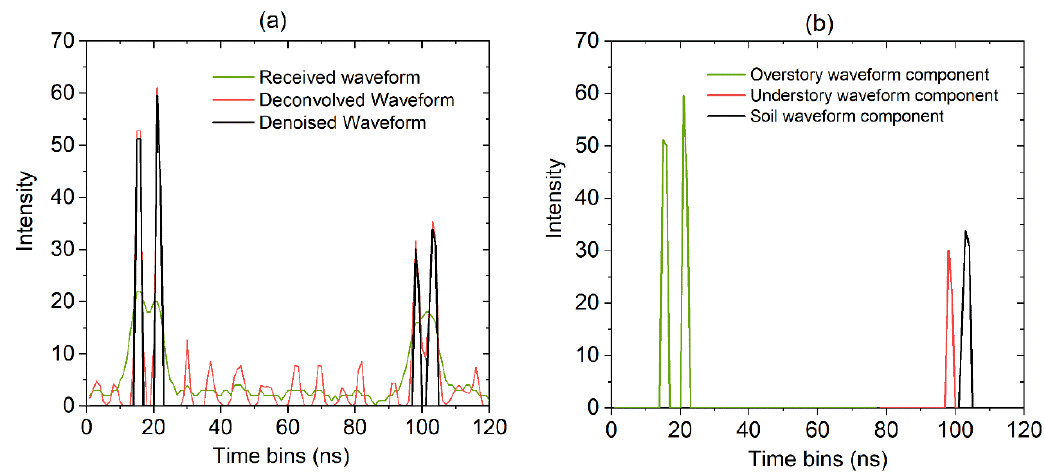
Figure 7. ( a ) A deconvolved and denoised waveform and ( b ) the corresponding decomposed waveform components.